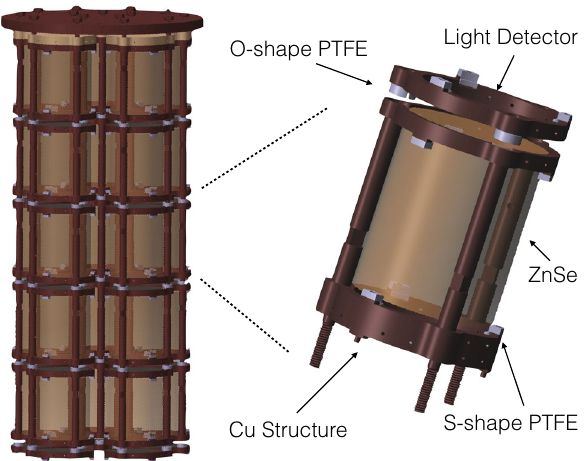
Fig. 2 Rendering of CUPID-0 detector and its single module